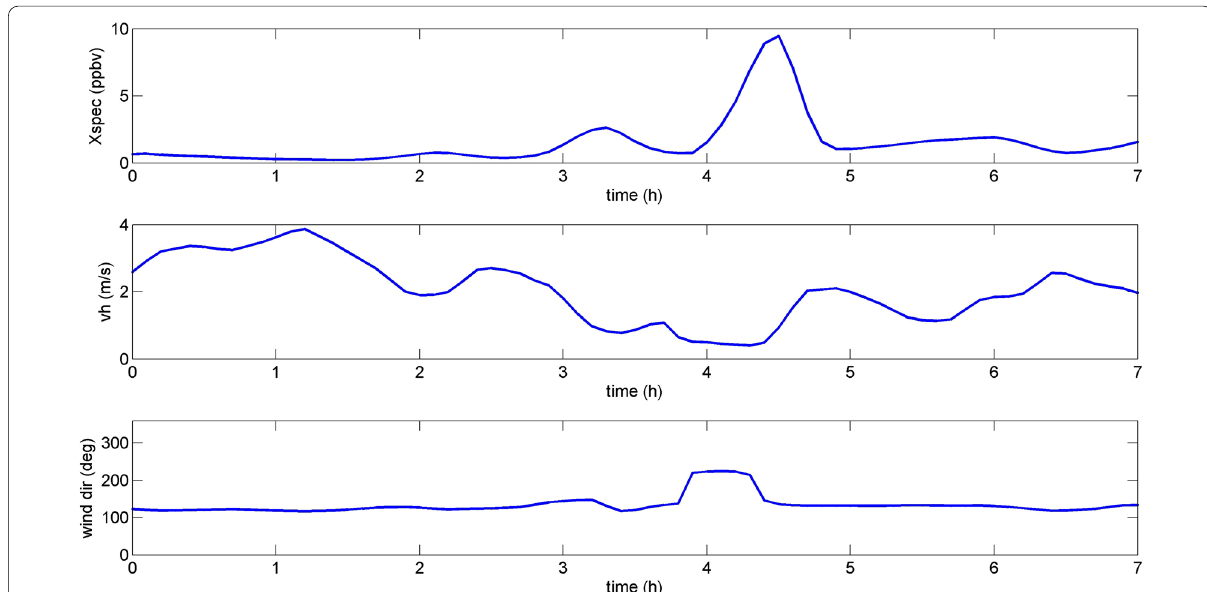
Fig. 10 Volume mixing ratio, horizontal wind speed (vh), and wind direction (Ψ d ) in the first prognosed layer at MSL’s location, covering the methane spike presented in Fig. 8 and produced by a source location at 4.7 deg of latitude, 137.4 deg of longitude. Wind direction is shown from which the wind is blowing, following the standard meteorological convention (0° < Ψ d